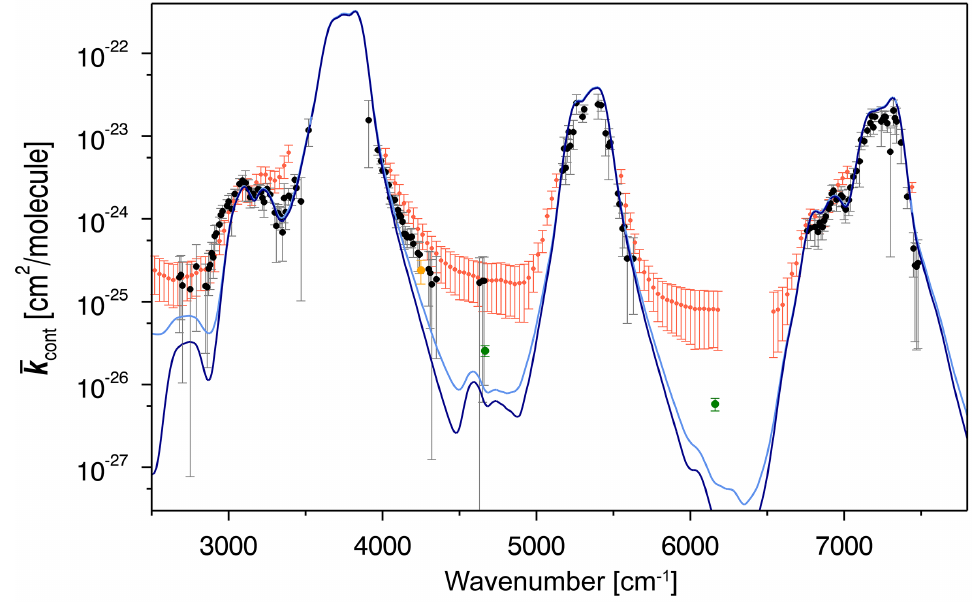
Figure 2. Mean continuum absorption coefficient ¯ k cont determined in the Zugspitze closure experiment and corresponding 2 σ uncertainties (black). The figure only includes data points for which the measured continuum exceeds the estimated uncertainty. A representation of the full set of measurement results is shown in Fig. B1. Results are compared to the MT_CKD 2.5.2 model (self- and foreign continuum: light blue; foreign continuum: dark blue), the BPS-MTCKD 2.0 model (purple line), and the following laboratory studies carried out at room temperature or below: the CRDS measurements of Mondelain et al. (2015) (orange), the calorimetric–interferometric measurements of Bicknell et al. (2006) (green), and the FTIR measurements of Ptashnik et al. (2012, 2013)